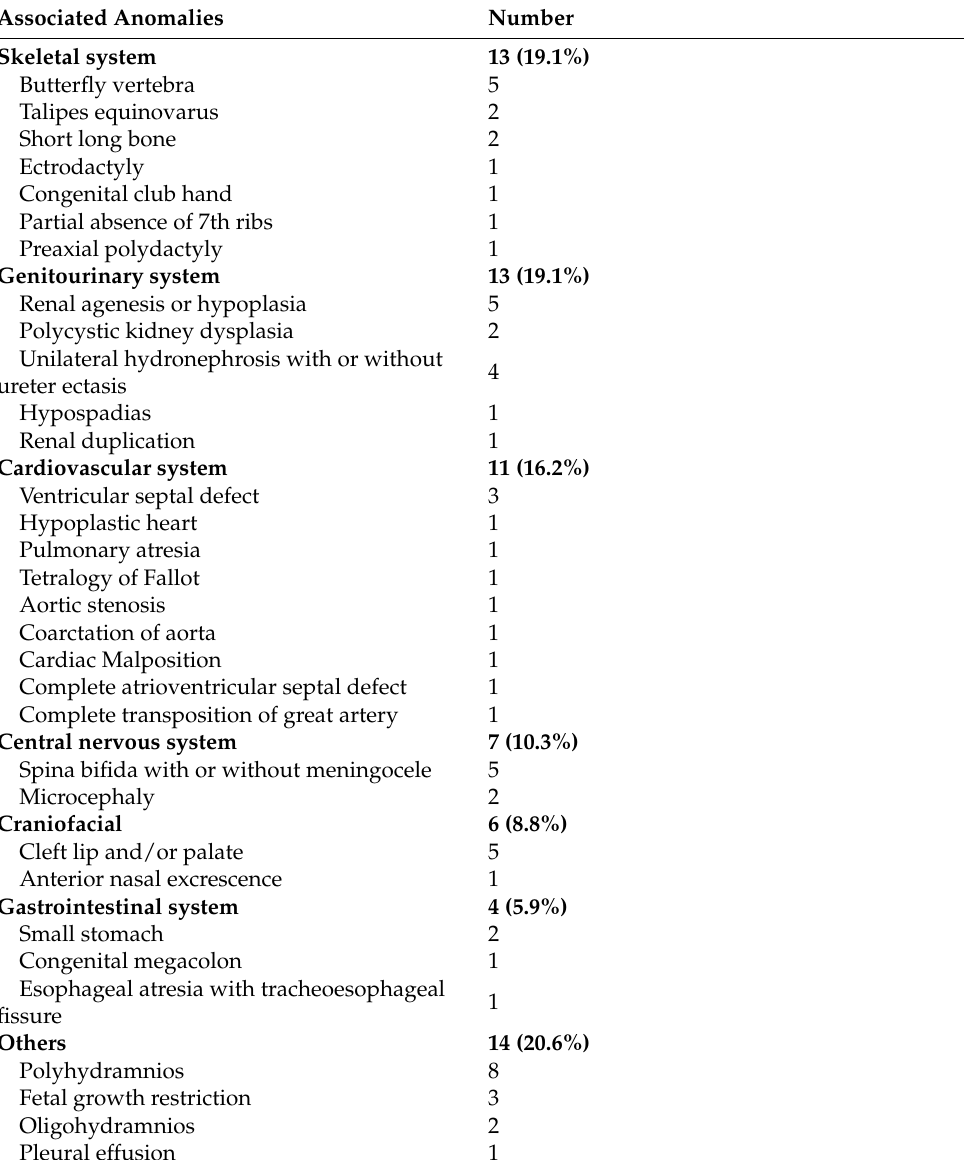
Table 2. Associated anomalies identified sonographically in fetuses with